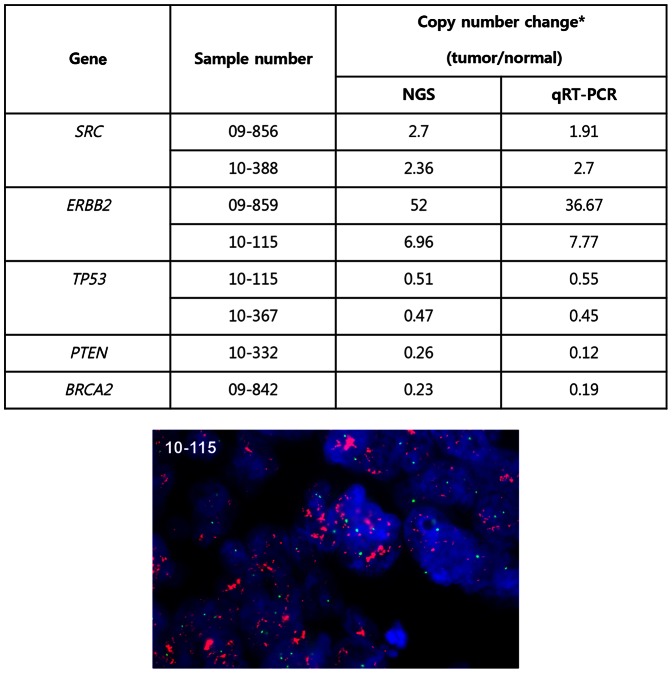
Validation of copy number variation.* Values are coverage fold ratios not adjusted for tumor purity. Representative image of FISH analysis of ERBB2 (red) and CEP17 (green) showing amplification of ERBB2.